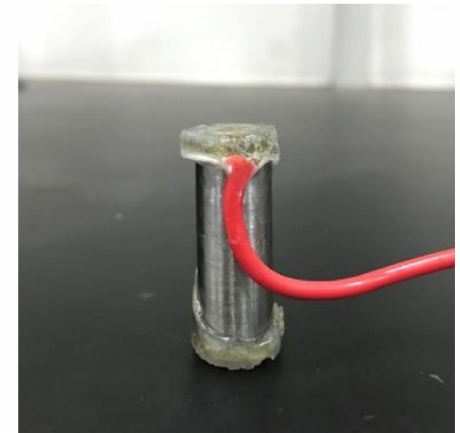
Figure 1. Coating steel